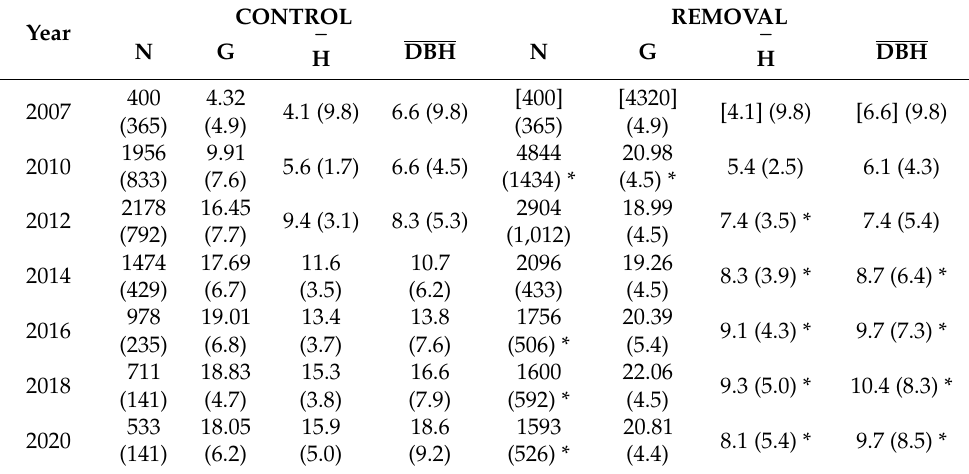
Table 2. Results of the analysis between control and removal for density (N, no. trees.ha − 1 ),